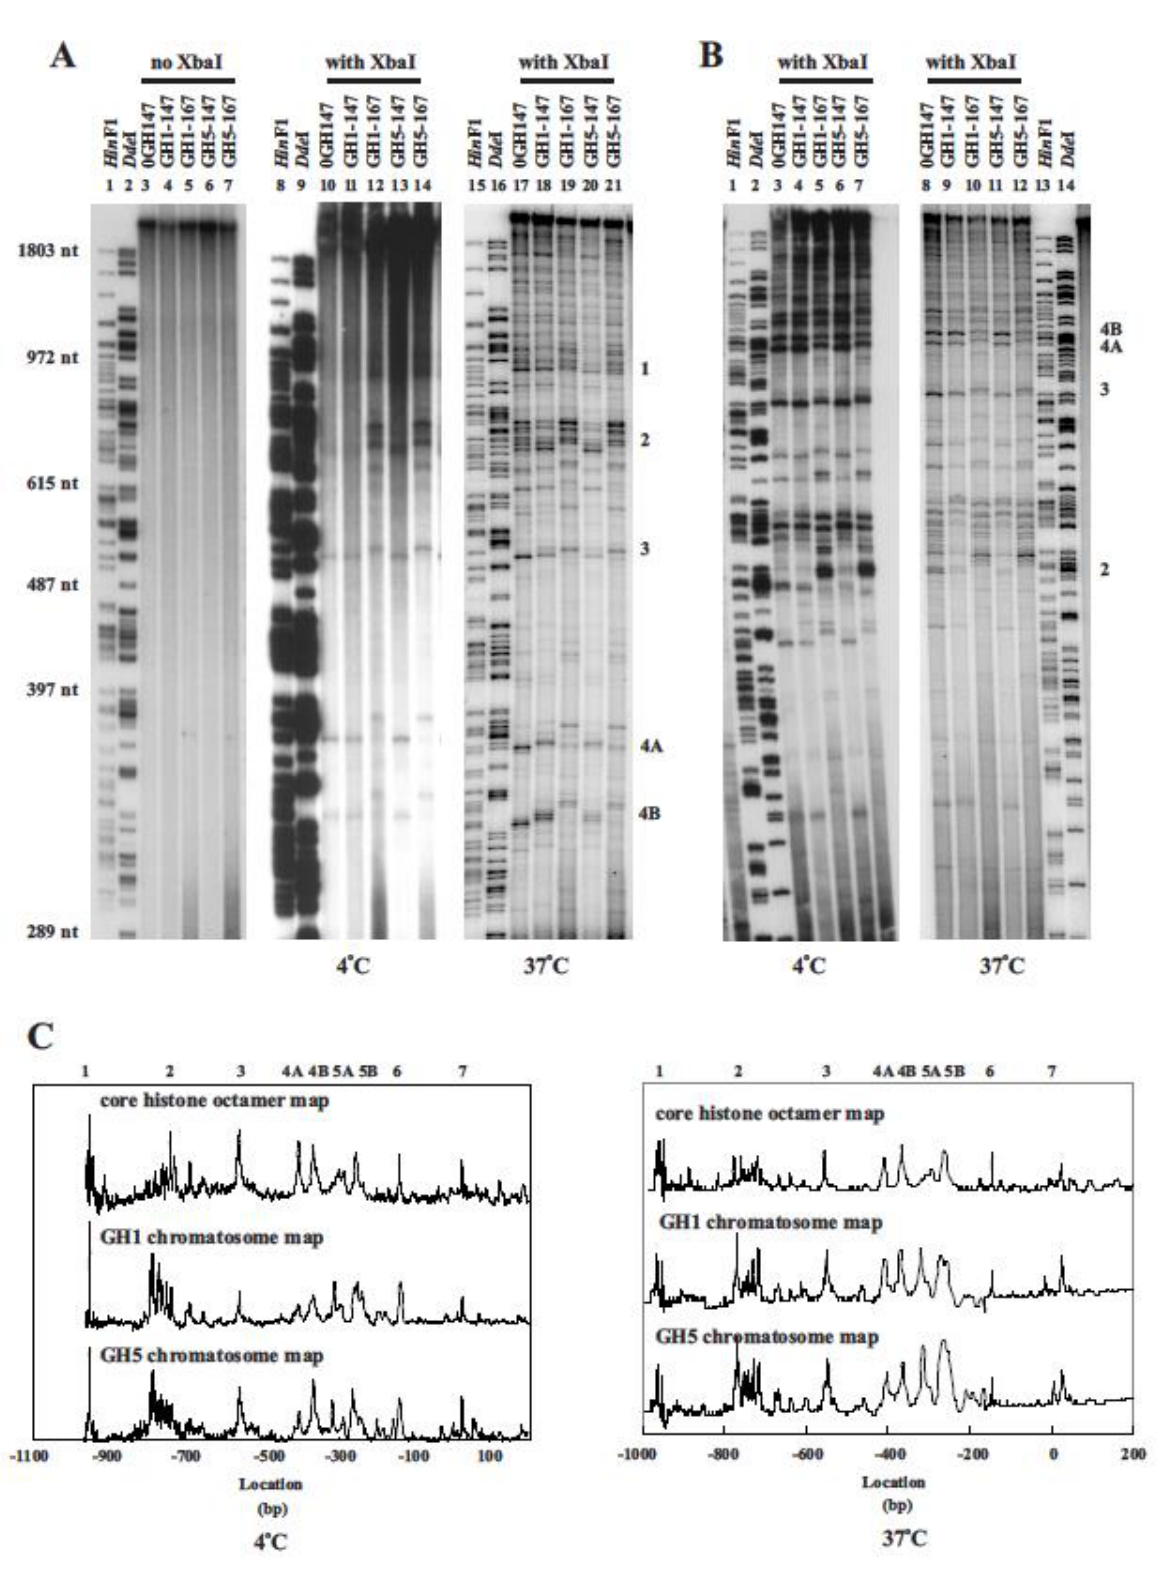
Figure 2. ( A ) A 6% denaturing polyacrylamide gel analysis of monomer extension products formed on mapping constructs EcSm (upstream) from 4 °C and 37 °C reconstitute condition. ( B ) A 6% denaturing polyacrylamide gel analysis of monomer extension products formed on mapping constructs SmEc (downstream) prepared from 4 °C and 37 °C reconstituted conditions. The names for each sample were as described in Figure 1. Size standards were Hin fI and Dde I digests of lambda DNA. Prominent core particle positioning sites or groups of sites previously identified were numbered as in Davey et al.